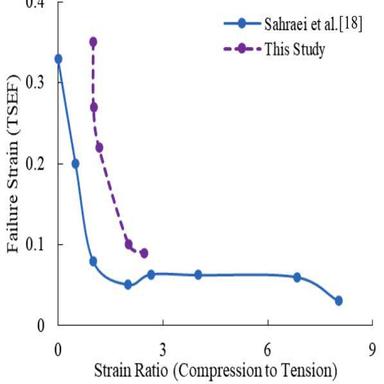
Comparison of failure locus in current study based on the ratio of compression to tensile strain with the work of Sahraei et al.. The same trend was observed in the simulations which can be used to develop a universal failure model.